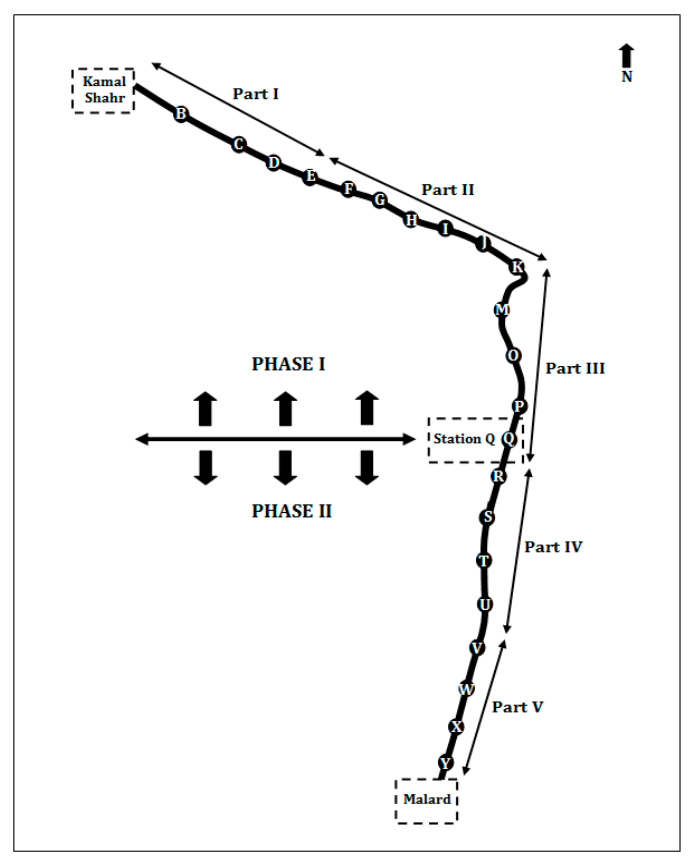
Figure 1. Schematic view of Line 2 of Karaj Urban Railway (KUR) with the location of subway stations.